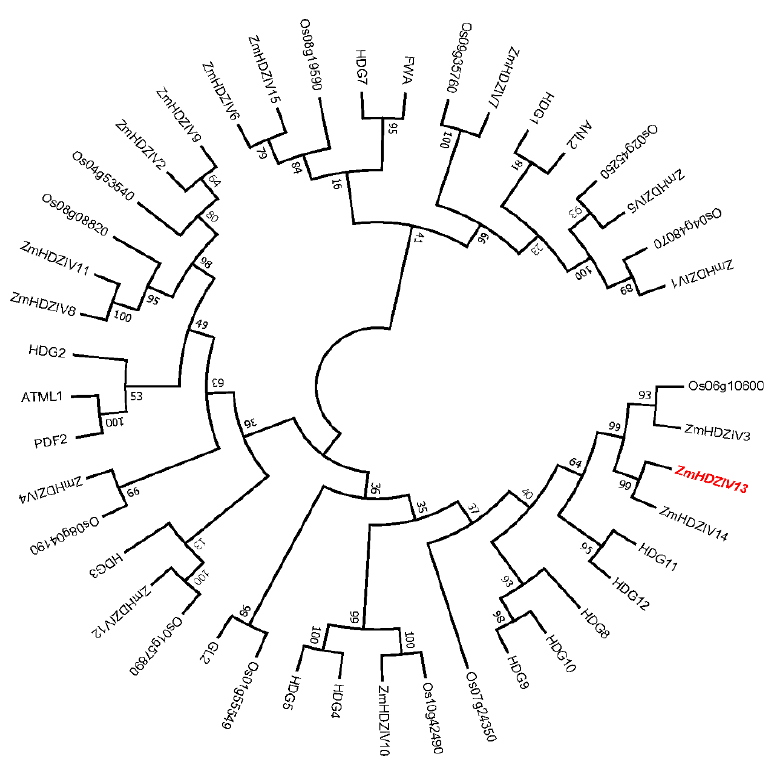
Figure 1. Homology analysis of ZmHDZIV13 and At HDG11 amino acid sequences.